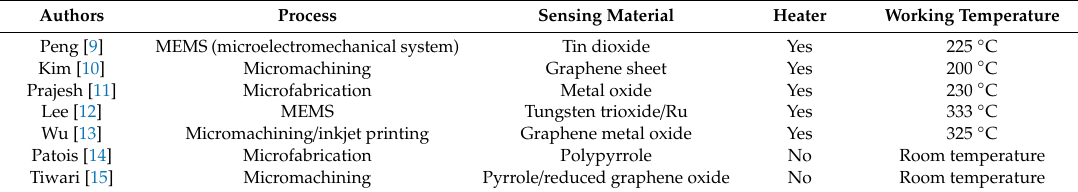
Table 1. Process and characteristic of various ammonia gas sensors